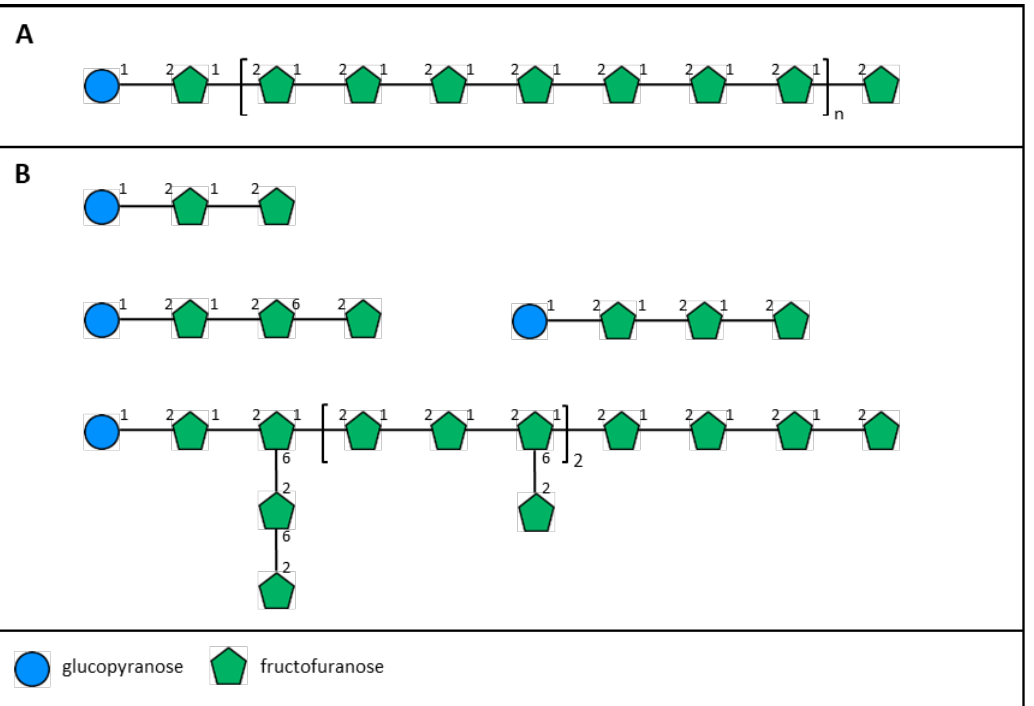
Figure 2. Schematic representations of ( A ) inulin and ( B ) trisaccharide, tetrasaccharides, and fructan from rengarenga.